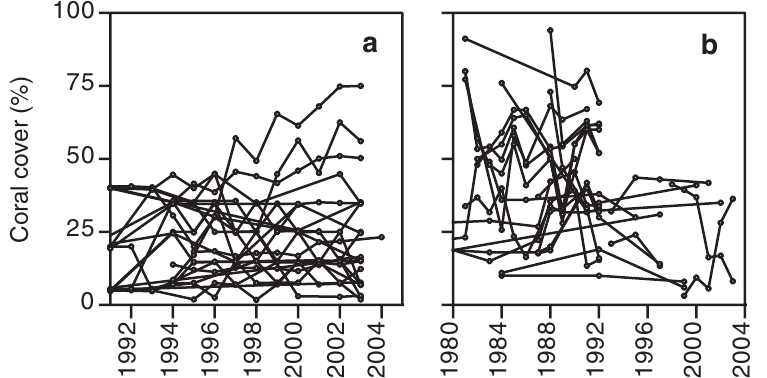
Figure 4. Illustrative examples of asynchrony of coral cover among 25 randomly selected monitored reefs on the GBR (a) and in Indonesia (b).